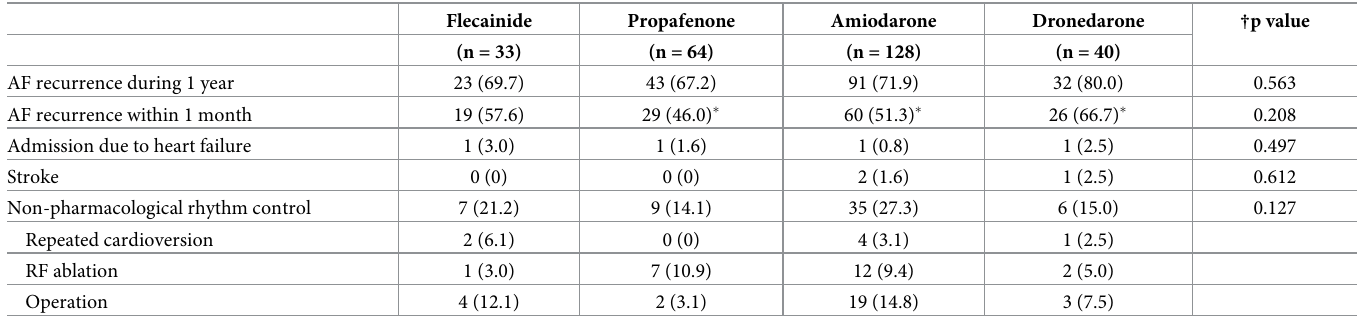
Table 2. Clinical outcomes according to antiarrhythmic drug